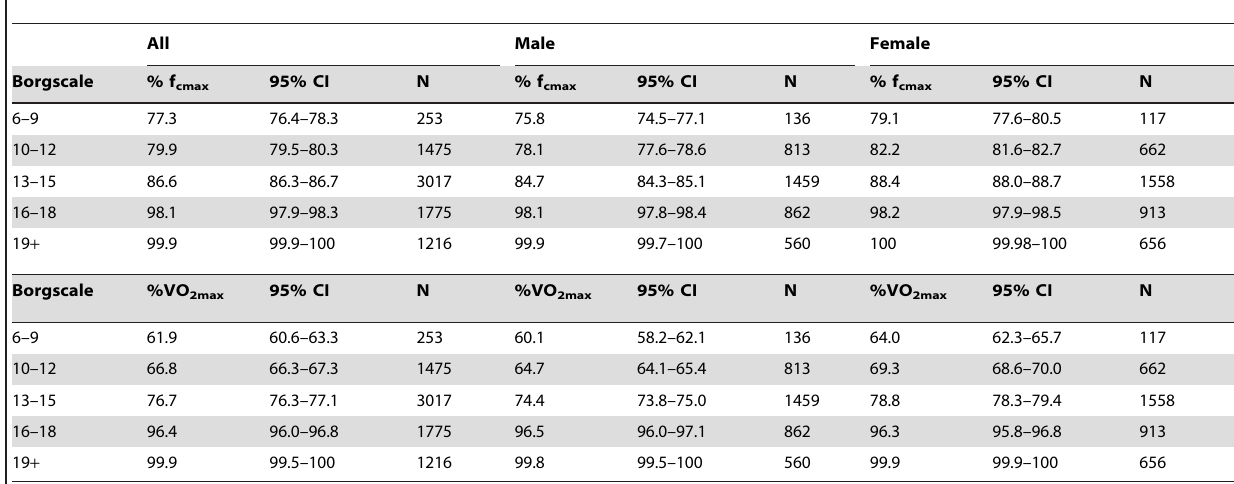
Table 4. Relationships between perceived exertion, VO 2max and f cmax in the HUNT 3 fitness study.